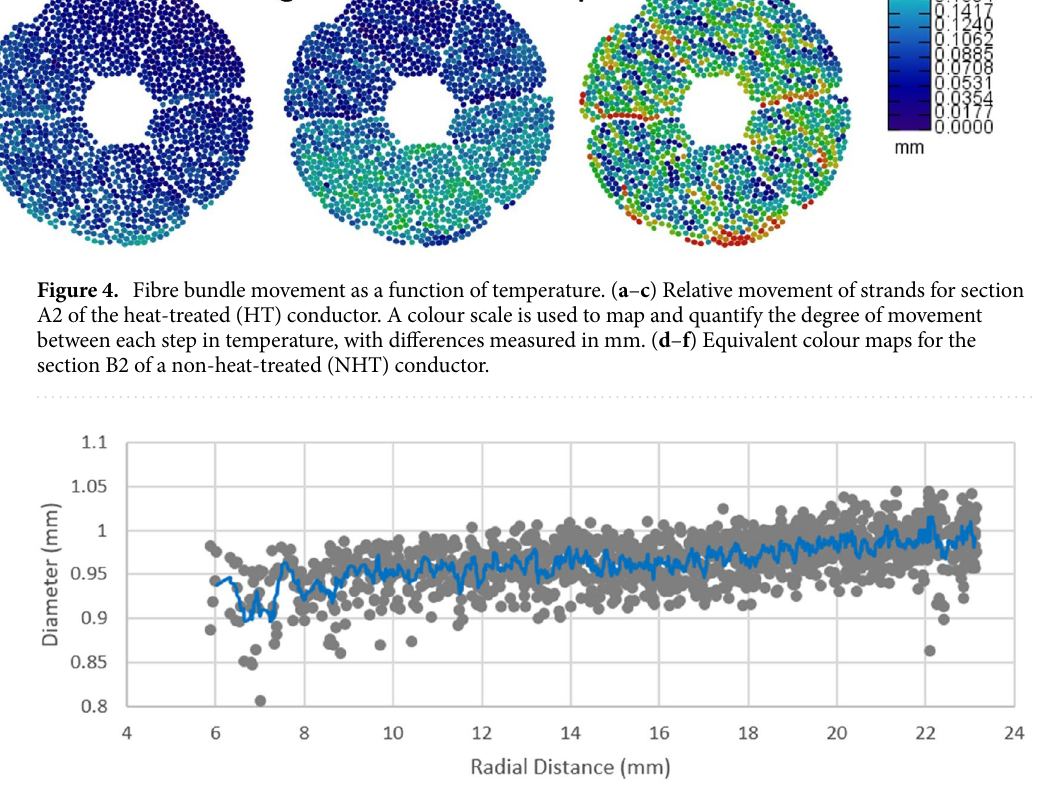
Figure 5. Fibre bundle effective diameter as a function of radial distance from the centre of the CICC. A gradual rise in bundle diameter is observed for the heat-treated sample with increasing distance from the jacket centre of